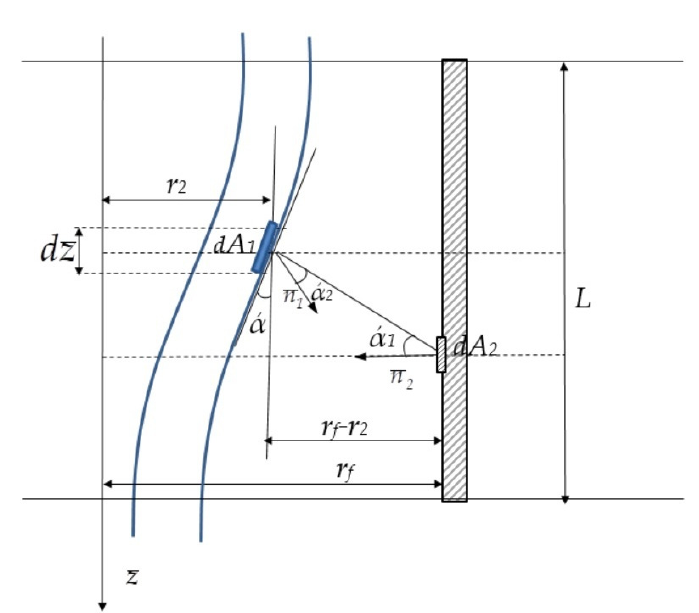
Figure 3. Radiant heat transfer during capillary drawing.